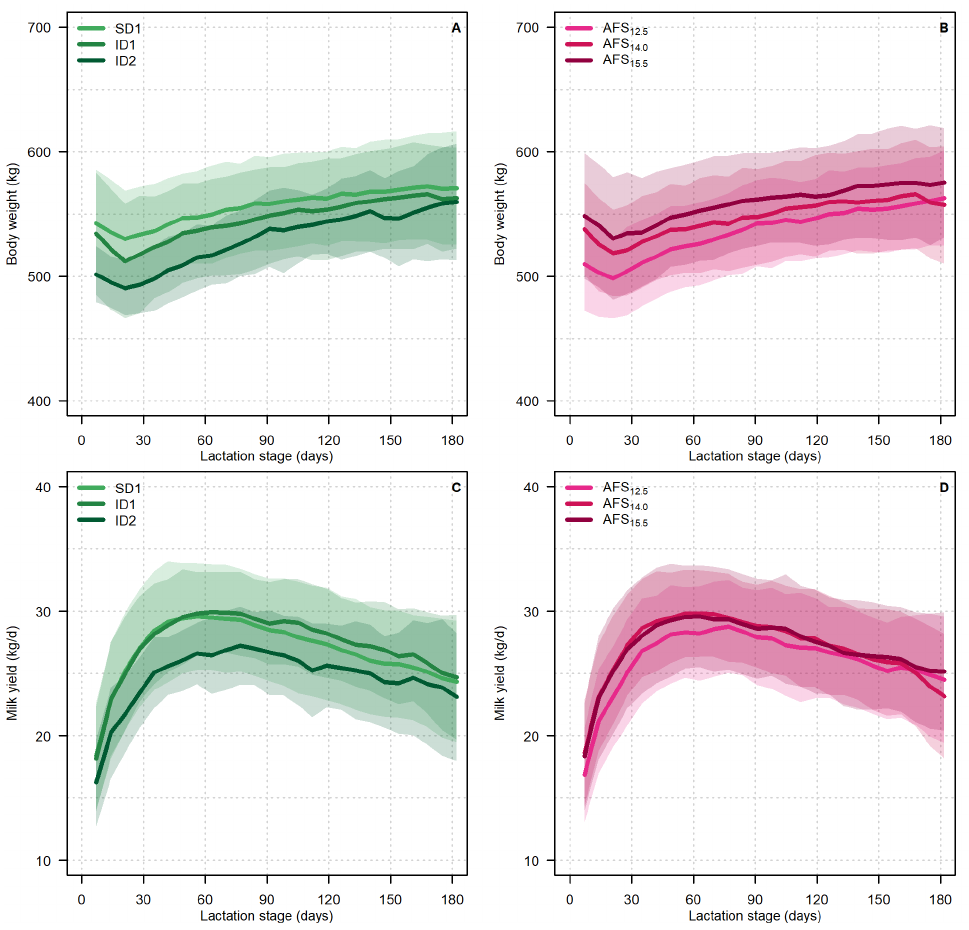
Figure 2. (A and B) body weight and (C and D) milk yield of primiparous cows during lactation by (A and C) feeding treatment (SD, ID1, ID2: animals fed a standard (SD) or increased-plane (ID1 & ID2) feeding treatment) and (B and D) class of age at first service (AFS). Shaded areas are the dispersions of the data around the means (± one standard